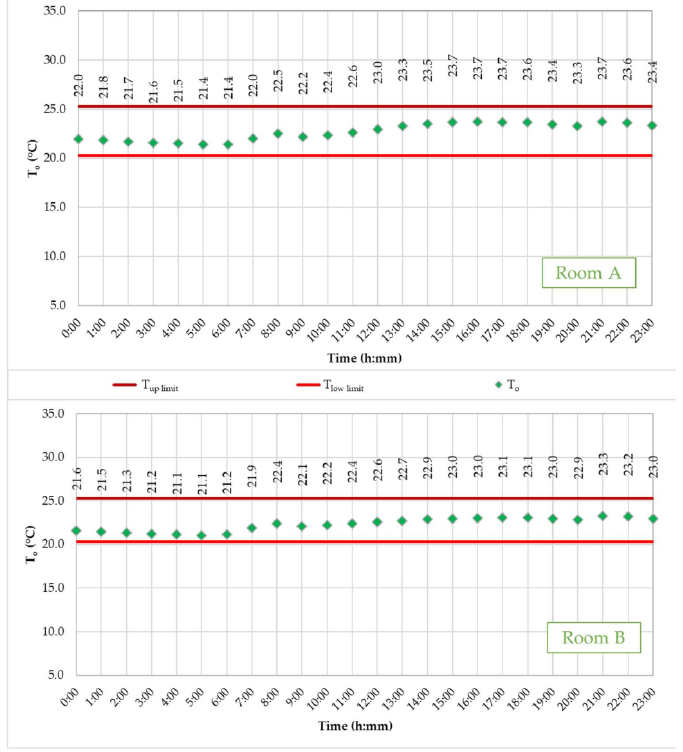
Figure 9. Hourly operative temperature for the spring